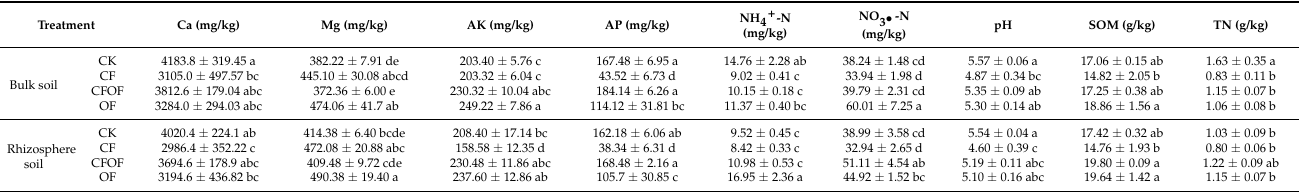
Table 3. Bulk and rhizosphere soil properties of different fertilization